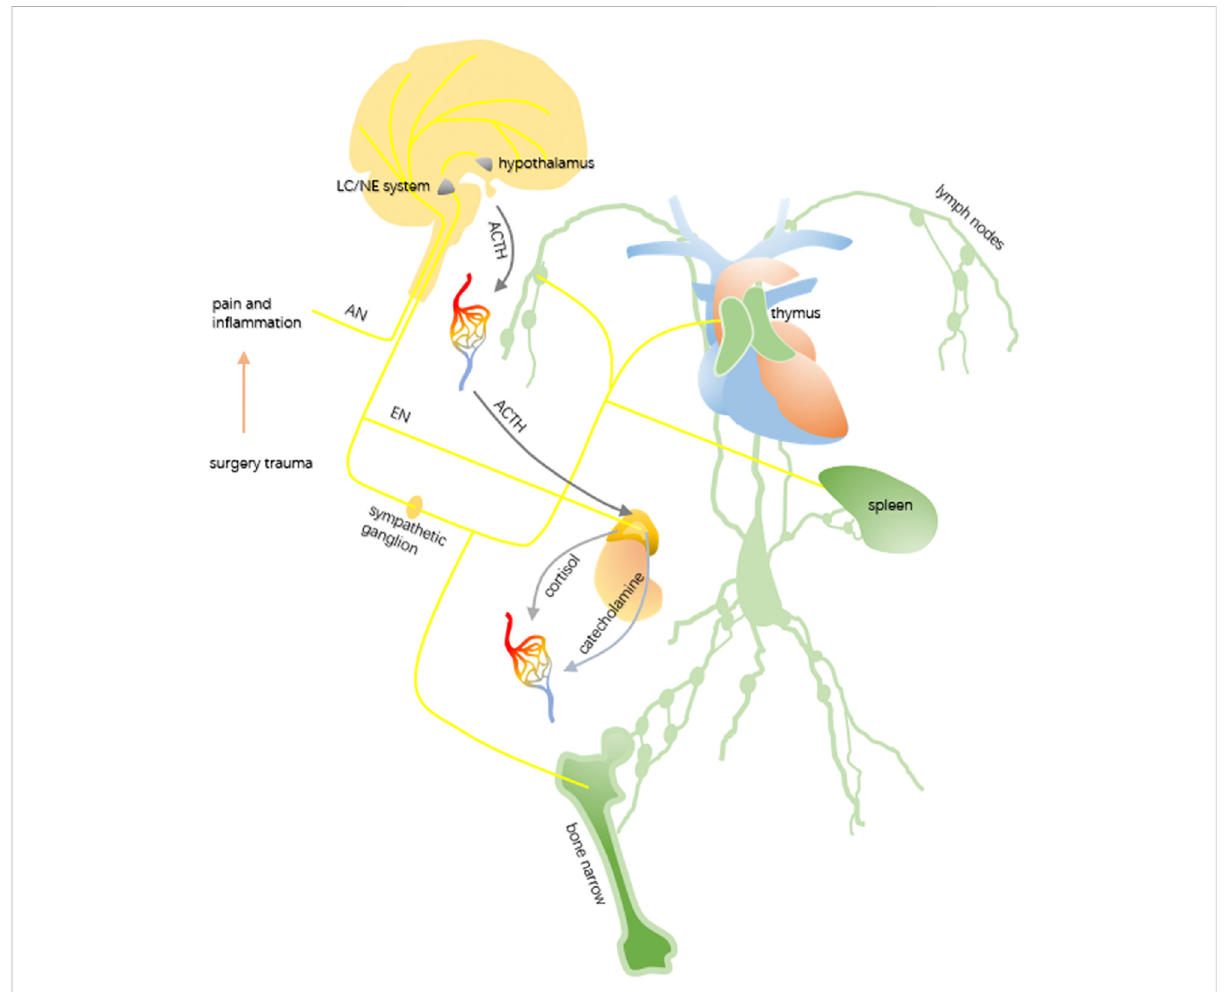
FIGURE 4 Simpli fi ed mechanism of immunosuppression induced by surgery damage. Tissue injury caused by surgery stimulates the afferent neuron (AE). The cerebrum accepts the stimulation, processes the information, and sends them to a special function unit. The locus coeruleus – noradrenergic system (LC/NE system) rapidly transmits the instruction to the immune organs and adrenal medulla through the efferent neuron (EN) and sympathetic nervous system (SNS). Affected by the hypothalamus, the anterior pituitary secretes the adrenocorticotropic hormone (ACTH) to promote the release of cortisol. Both of these contribute to the inhibition of the immune